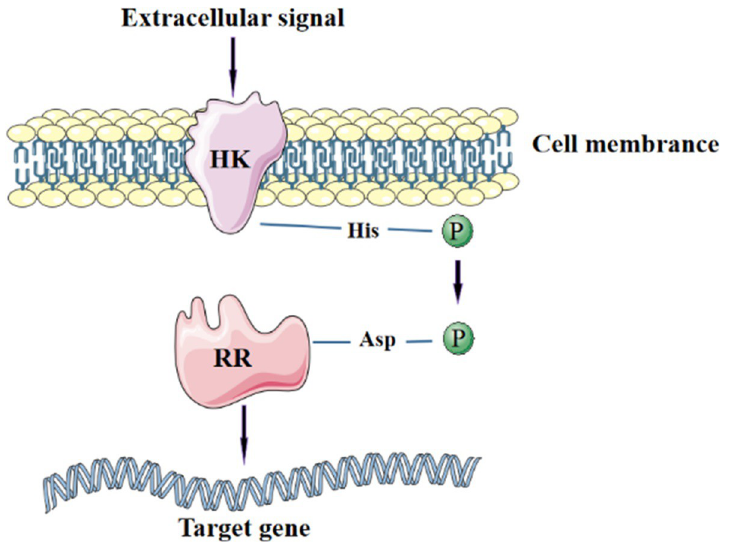
Fig 1. Mechanism of the two-component